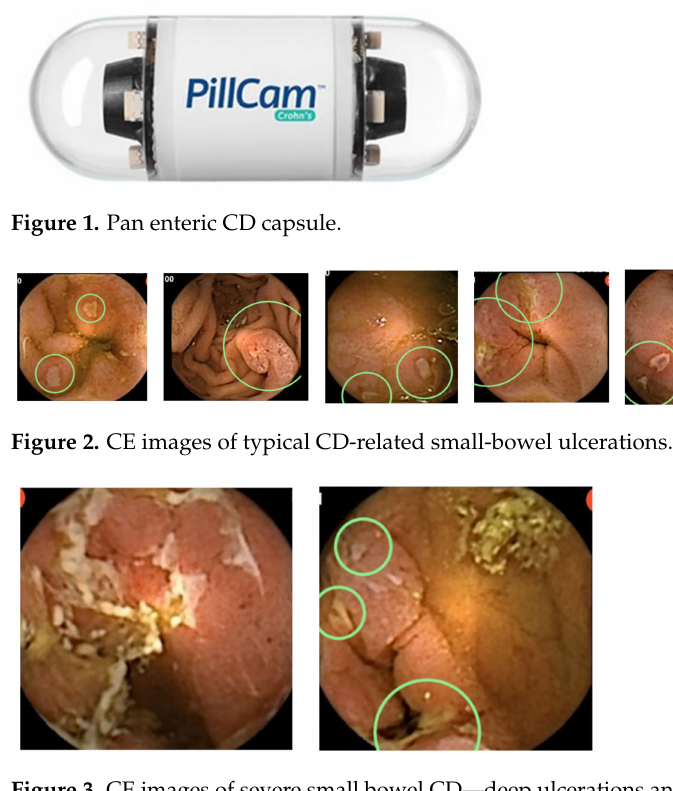
Figure 3. CE images of severe small bowel CD—deep ulcerations and extended disease, including lu- men narrowing. The green circles mark pathological findings consistent with CD-ulcers and